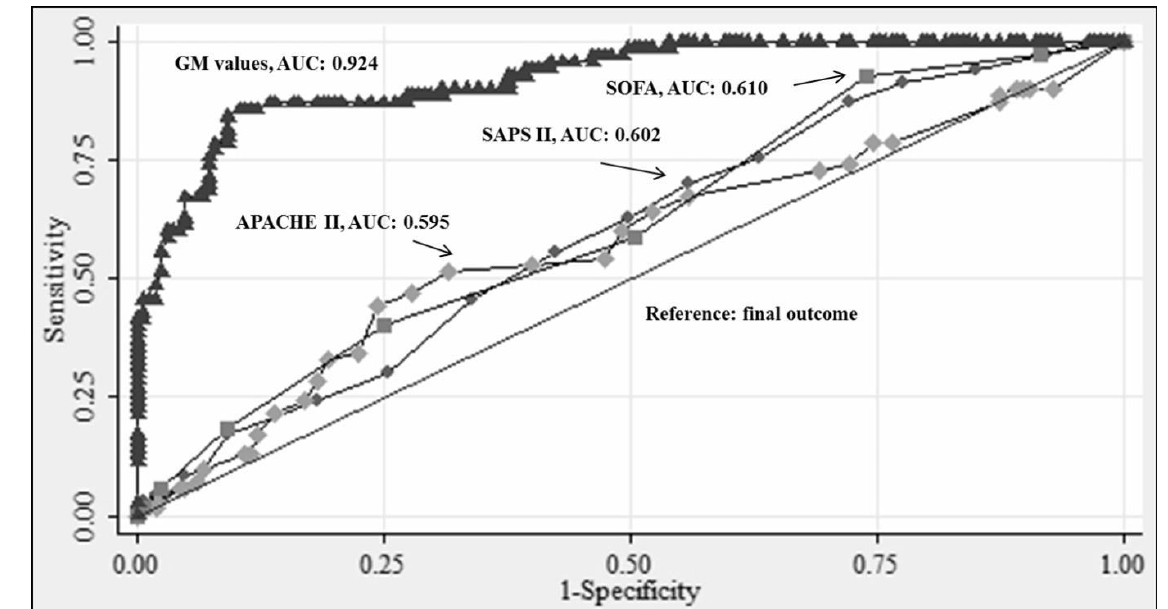
Figure 3. Area under (AUC) receiver operating characteristic (ROC) curves of severity scores (APACHE II, SAPS II, and SOFA) and galactomannan (GM) values. (where APACHE II: Acute Physiology and Chronic Health Evaluation II; SOFA: Sequential Organ Failure Assessment; SAPS II: Simplified Acute Physiology Score II) Table 5. Area under the receiver operating characteristic (ROC) curve, Hosmer – Lemeshow goodness-of-fit statistics, and predicted and standardized mortality ratios.